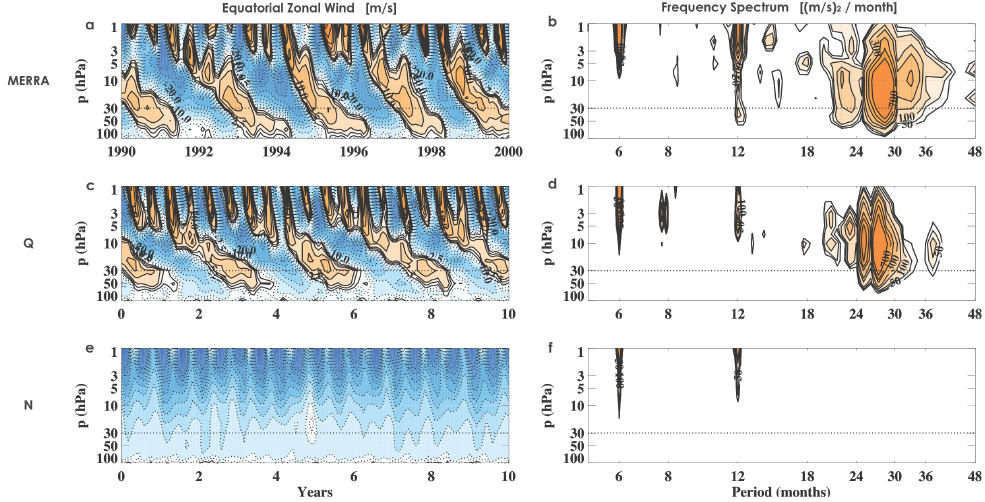
Figure 2 : Equatorial (4°S–4°N) zonal wind [m s -1 ] in (a–b) MERRA reanalysis, 1979–2012, (c–d) the Q simulation, and (e–f) the N simulation. (a, c, e) 10–year timeseries. (b, d, f) frequency spectra for the entire span of the MERRA reanalysis and GEOSCCM simulations. Black dotted lines indicate the 30–hPa level.